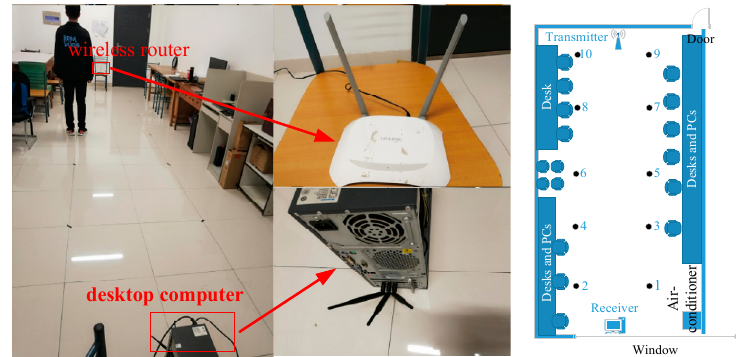
Figure 6. Experimental environment and